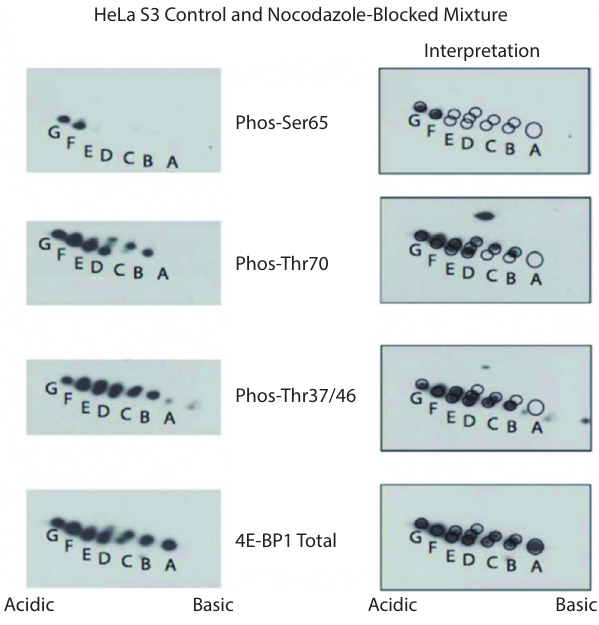
Figure 3. 4E-BP1 phosphorylation is not strictly ordered. Untreated and nocodazole-blocked HeLa S3 cells lysed, pooled and subjected to 2D-E prior to analysis with phospho-specific and total 4E-BP1 antibodies (left panels). In addition to the standard ordered phosphorylation (Thr37 or Thr46, then “spot B”, then Thr70, then “spot E”, then Ser65, then “spot G”), 4E-BP1 singly phosphorylated at Thr70 is also observed indicating that this species can exist in vivo . To facilitate interpretation, the same images have been overlaid with a grid of circles corresponding to spots visible with the total 4E-BP1 antibody (right